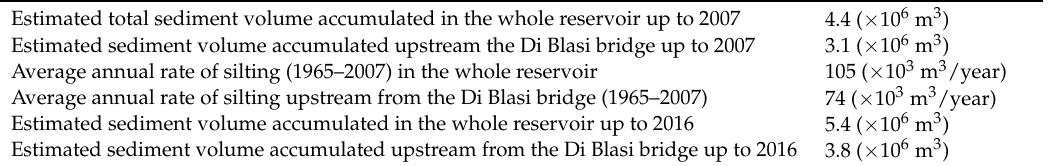
Table 5. Guardialfiera Reservoir sediment volumes and average annual